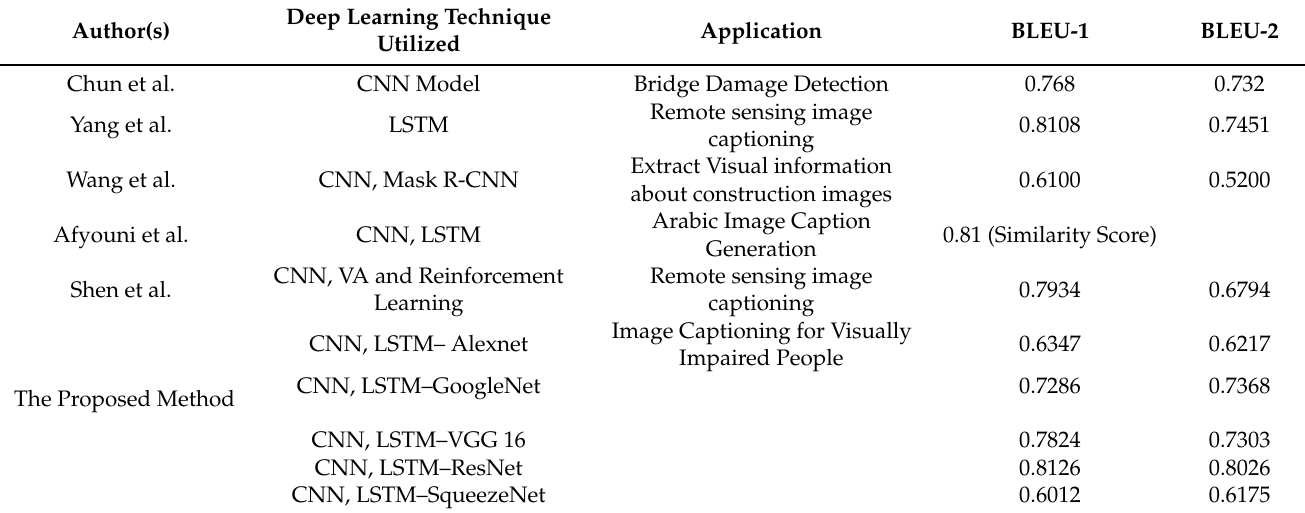
Table 6. The Performance Comparison with Existing